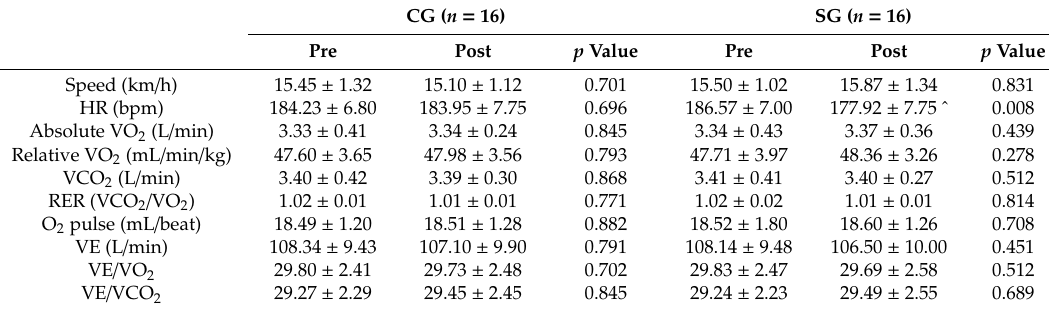
Table 5. Ergospirometric values at VT2.